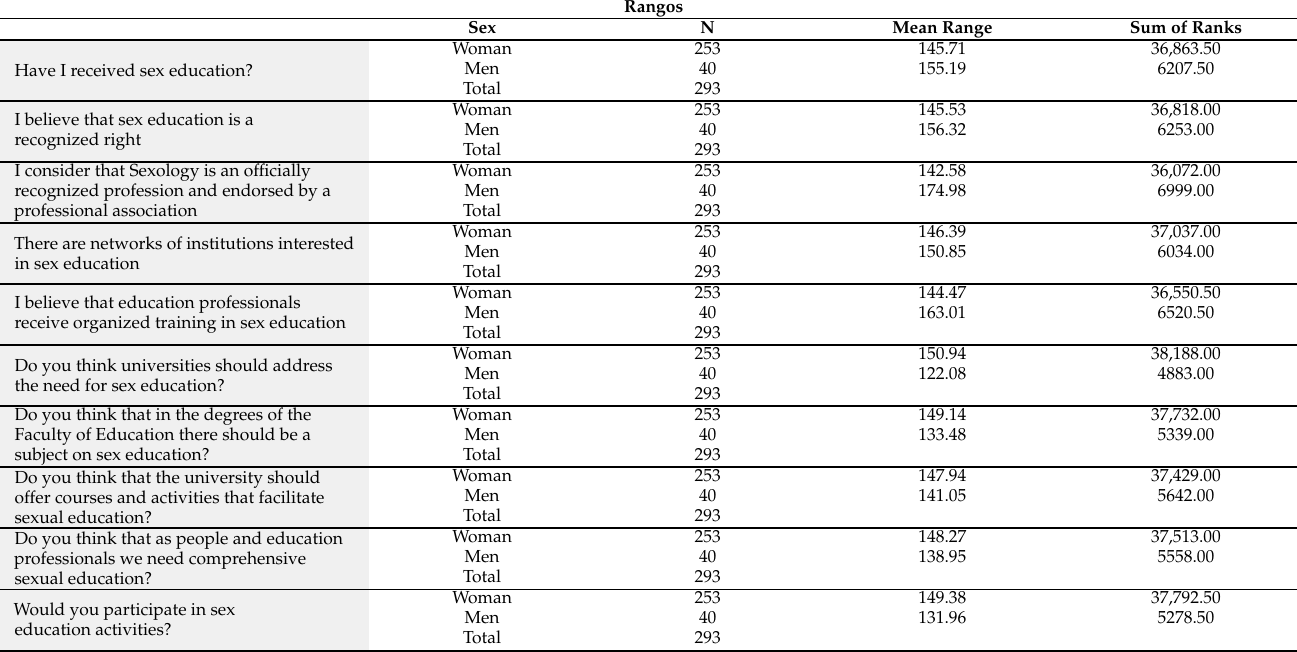
Table 5. Average range according to